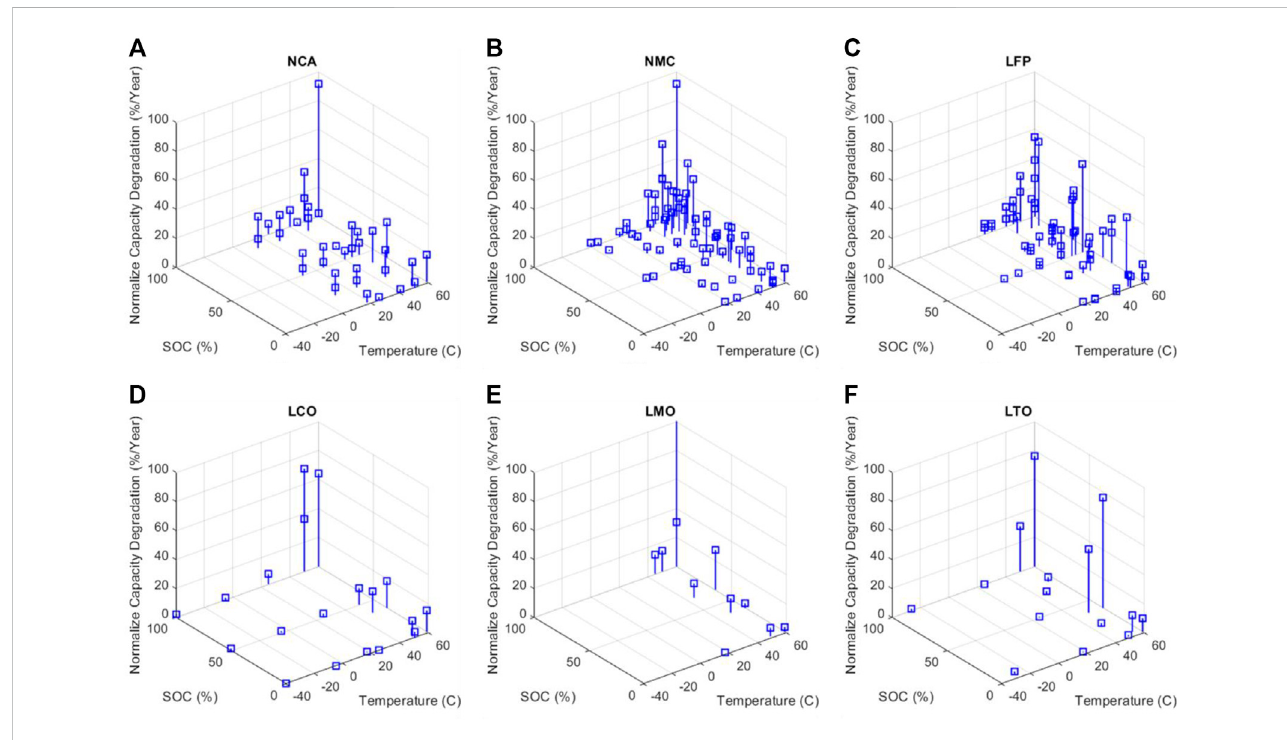
FIGURE 3 Empirical measurements of calendar aging reported in the literature. (A) , (B) , (C) , (D) , (E) , (F)